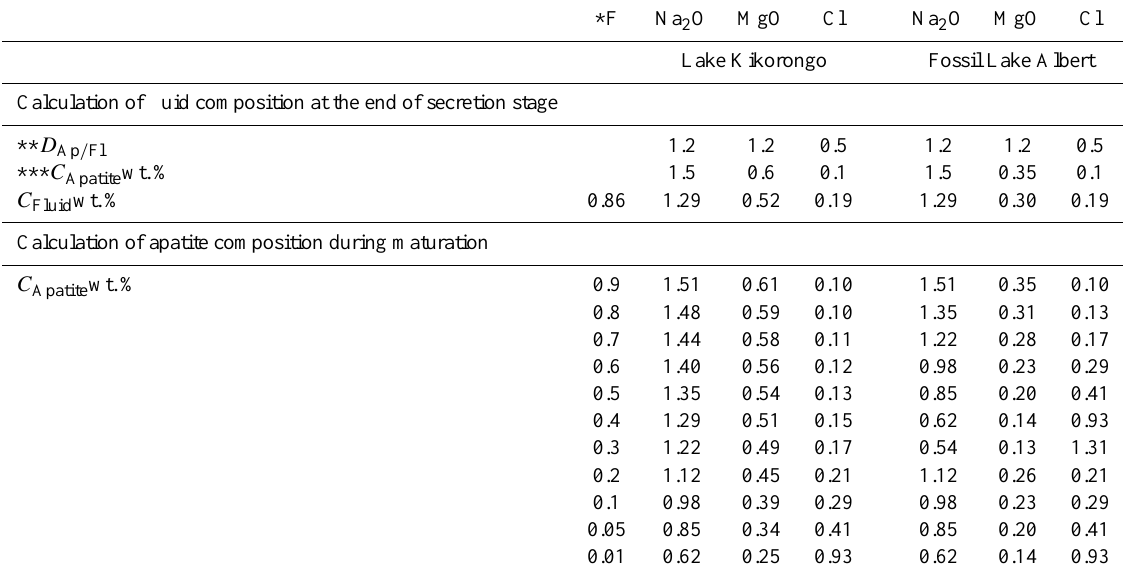
Table 6. Rayleigh crystallization model for enamel formation.